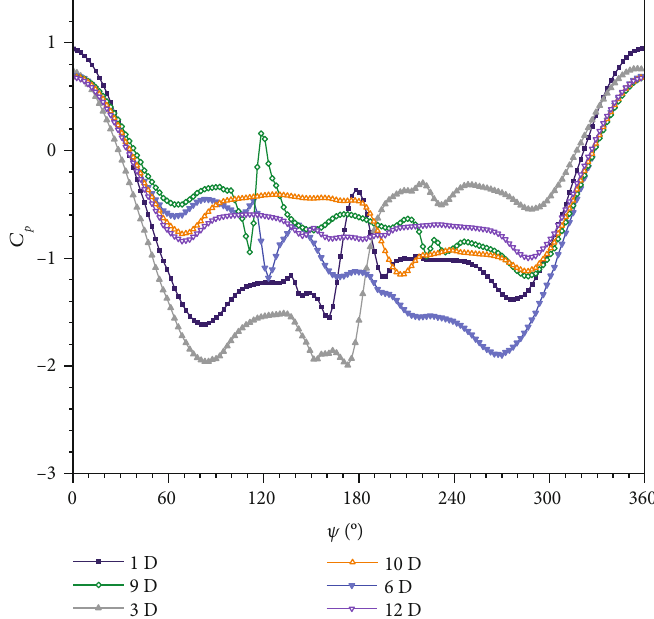
Figure 44: The pressure coe ffi cient of di ff erent sections varies with the roll angle at Model 4 with R a = 100 μ